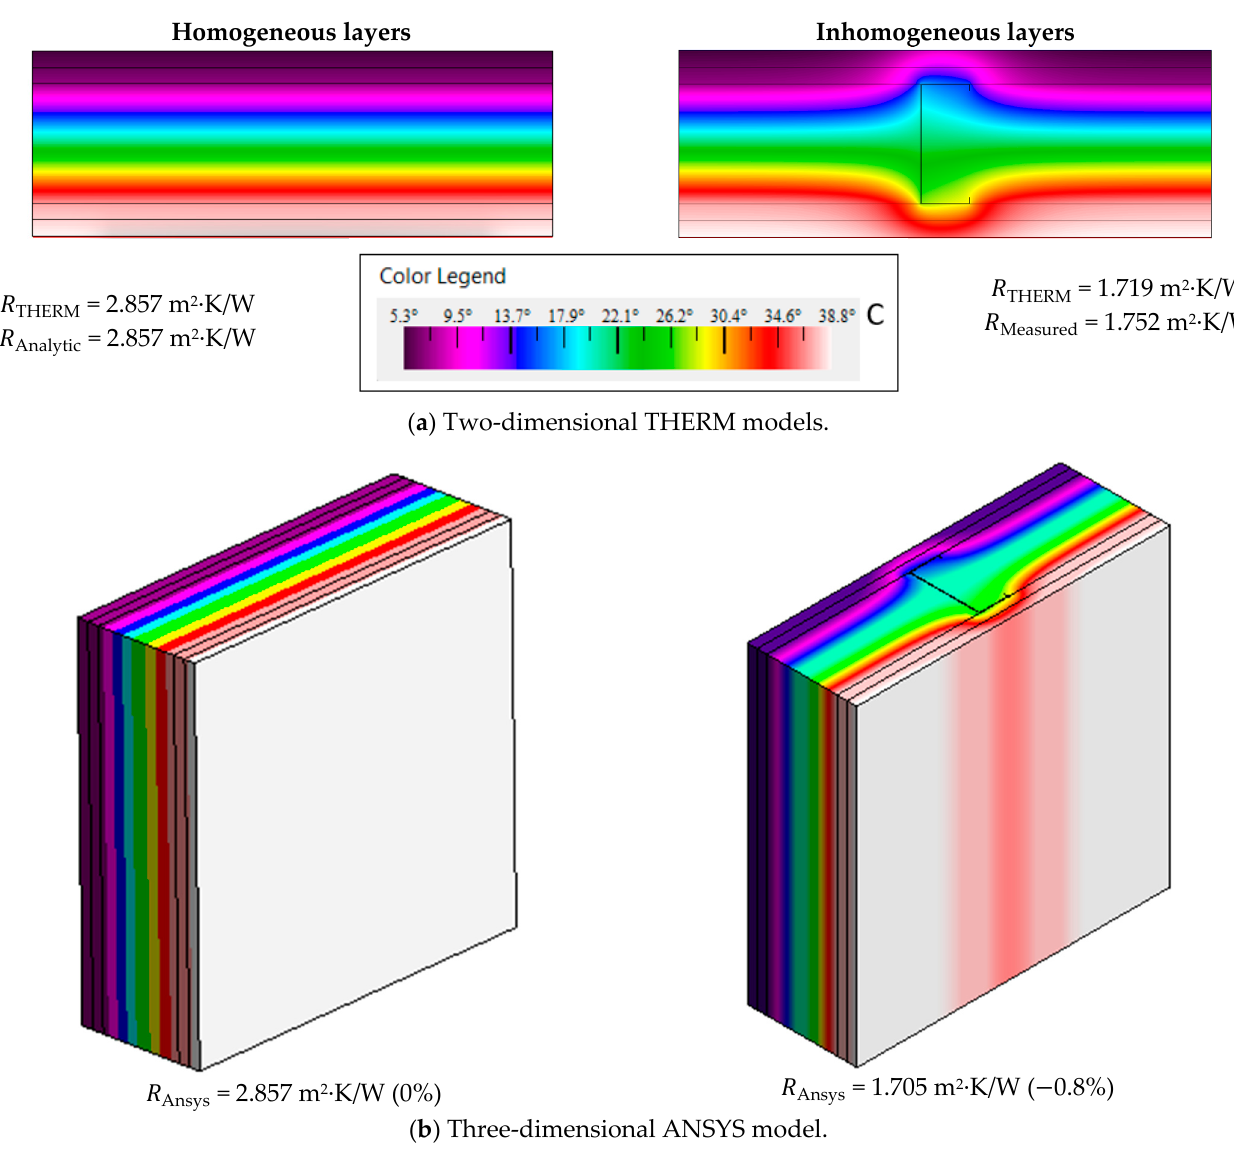
Figure 5. THERM models’ accuracy: conductive thermal resistances and temperature distribution.